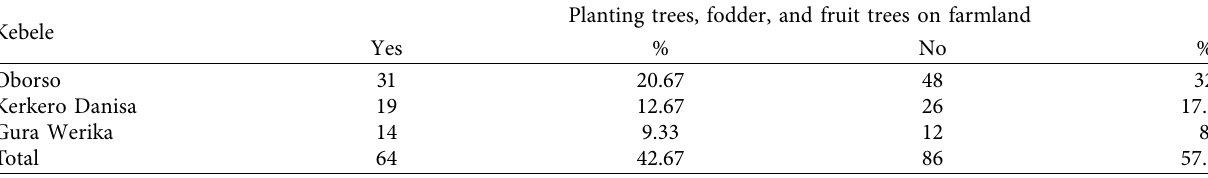
Table 9: Respondents planted seedlings on farmland. Planting trees, fodder, and fruit trees on